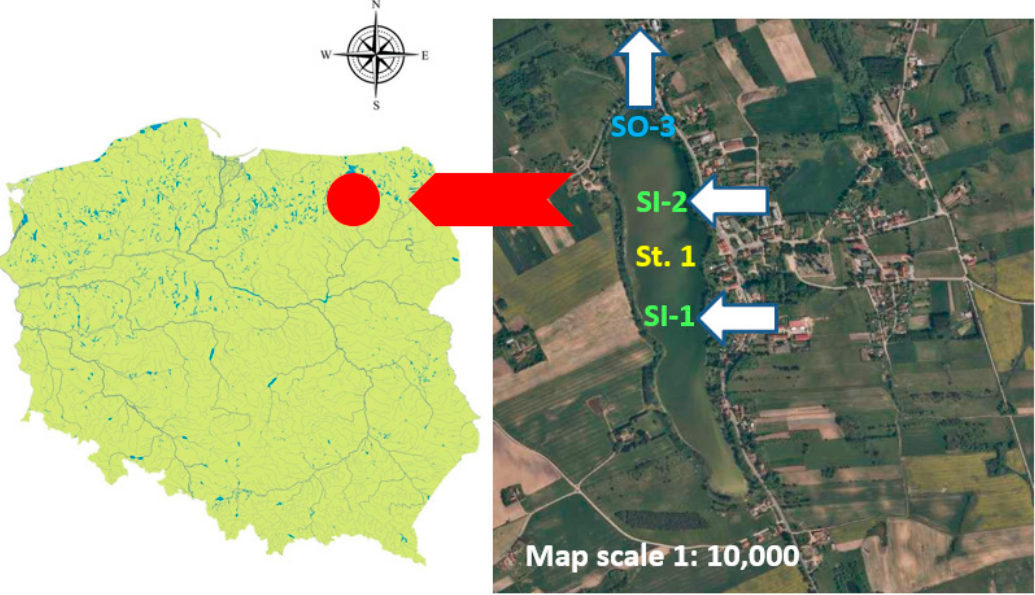
Figure 1. Miłkowskie Lake’s location and the site of water sample collection. Table 1. Morphometric parameters of Miłkowskie Lake. (Inland Fisheries Institute in Olsztyn, 1975).